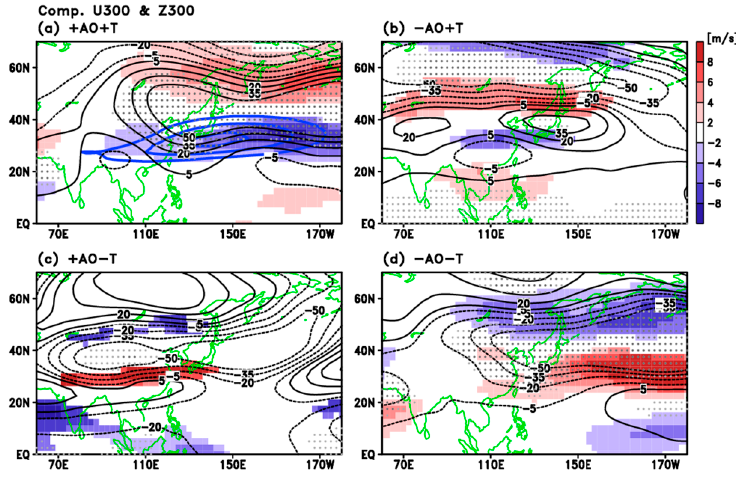
Figure 3. Composite maps of zonal wind (shading) and geopotential height (black contour) anomalies at 300 hPa in winter season for ( a ) +AO+T, ( b ) − AO+T, ( c ) +AO − T, and ( d ) − AO − T group. Blue contours in ( a ) indicate climatological zonal wind at 300hPa in winter season (larger than 40m/s with interval 10 m/s). Light (dark) gray contours denote boundaries of area which satisfy 90% (95%) confidence level through the two-tailed Student’s T-test. Zonal wind is shaded only for the grids which satisfy 90% confidence level.